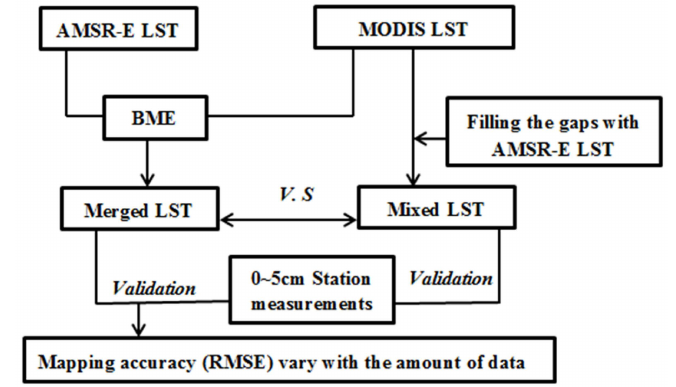
Figure 3. Schematic flow diagram for the blending MODIS and AMSR-E LST using the BME